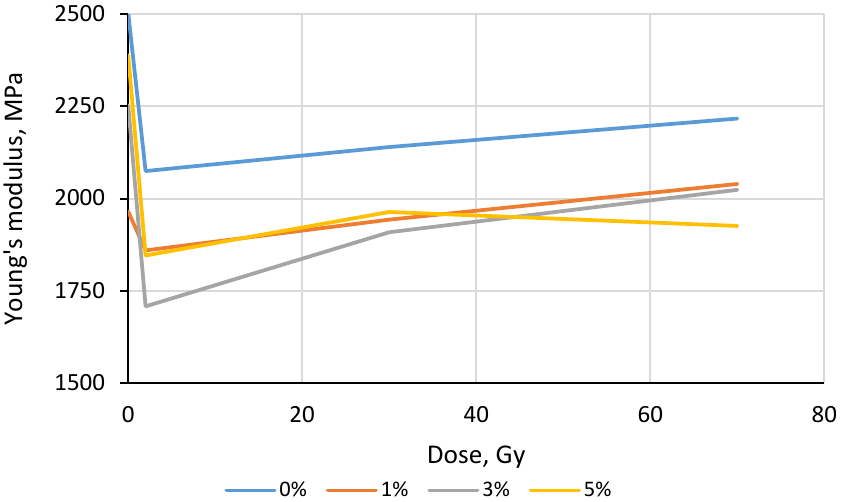
Figure 9. Variations in Young’s modulus of irradiated ABS samples with different concentrations of TiO 2 fi ller.